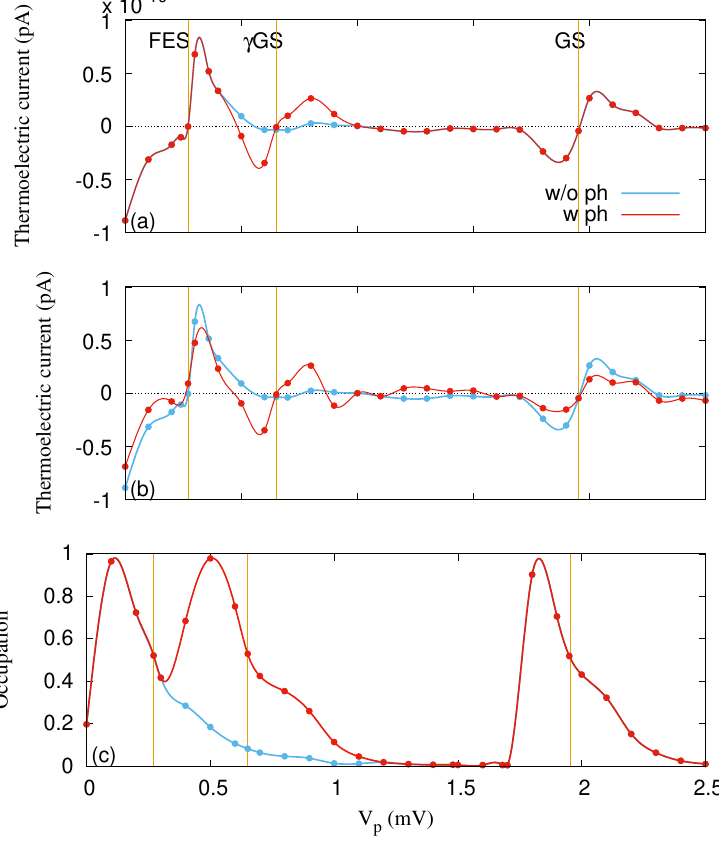
Figure 4. Thermoelectric current ( I L ) in the case of ¯ n R = 0 ( a ) and 1 ( b ), and electron occupation ( c ) for the QD system without (w/o ph) (blue color) and with (w ph) (red color) photon field. The photon energy is ¯ h ω γ = 1.31 meV (off-resonance regime), g γ = 0.05 meV, and the photon field is polarized in the x -direction. The temperature of the left lead is T L = 1.16 K and that of the right lead is T R = 0.58 K, which raises the thermal energy of the left lead to 0.1 meV and of the right lead to 0.05 meV. The chemical potential of the leads are fixed at µ L = µ R = 1.2 meV. The golden vertical lines display the resonance condition for the GS at V p = 1.95 mV, the γ GS at V p = 0.65 mV, and the FES at V p = 0.271 meV. The weak external magnetic field is B = 0.1 T, and ¯ h Ω 0 = 2.0